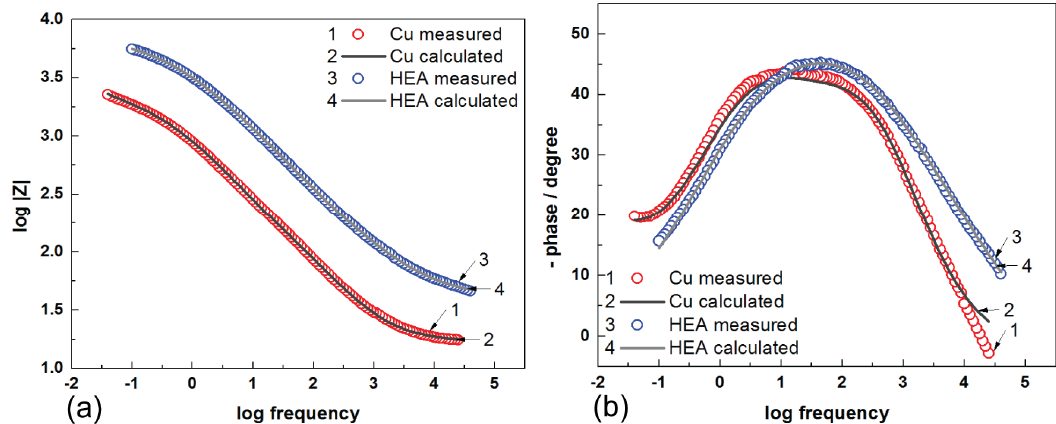
Figure 8. The Bode diagrams: ( a ) log freq. vs. log|Z| and ( b ) log freq. vs . –Phase, of the Cu and Cu–HEA electrodes in artificial seawater. Lines represent the modeled data according to the EECs from Figure 7.